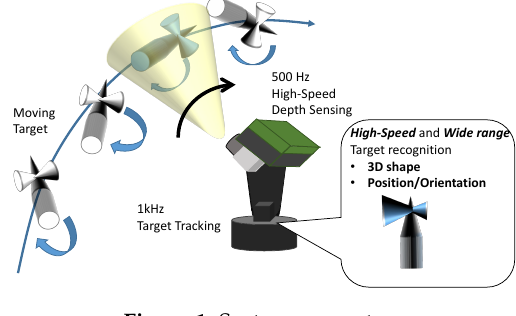
Figure 1. System